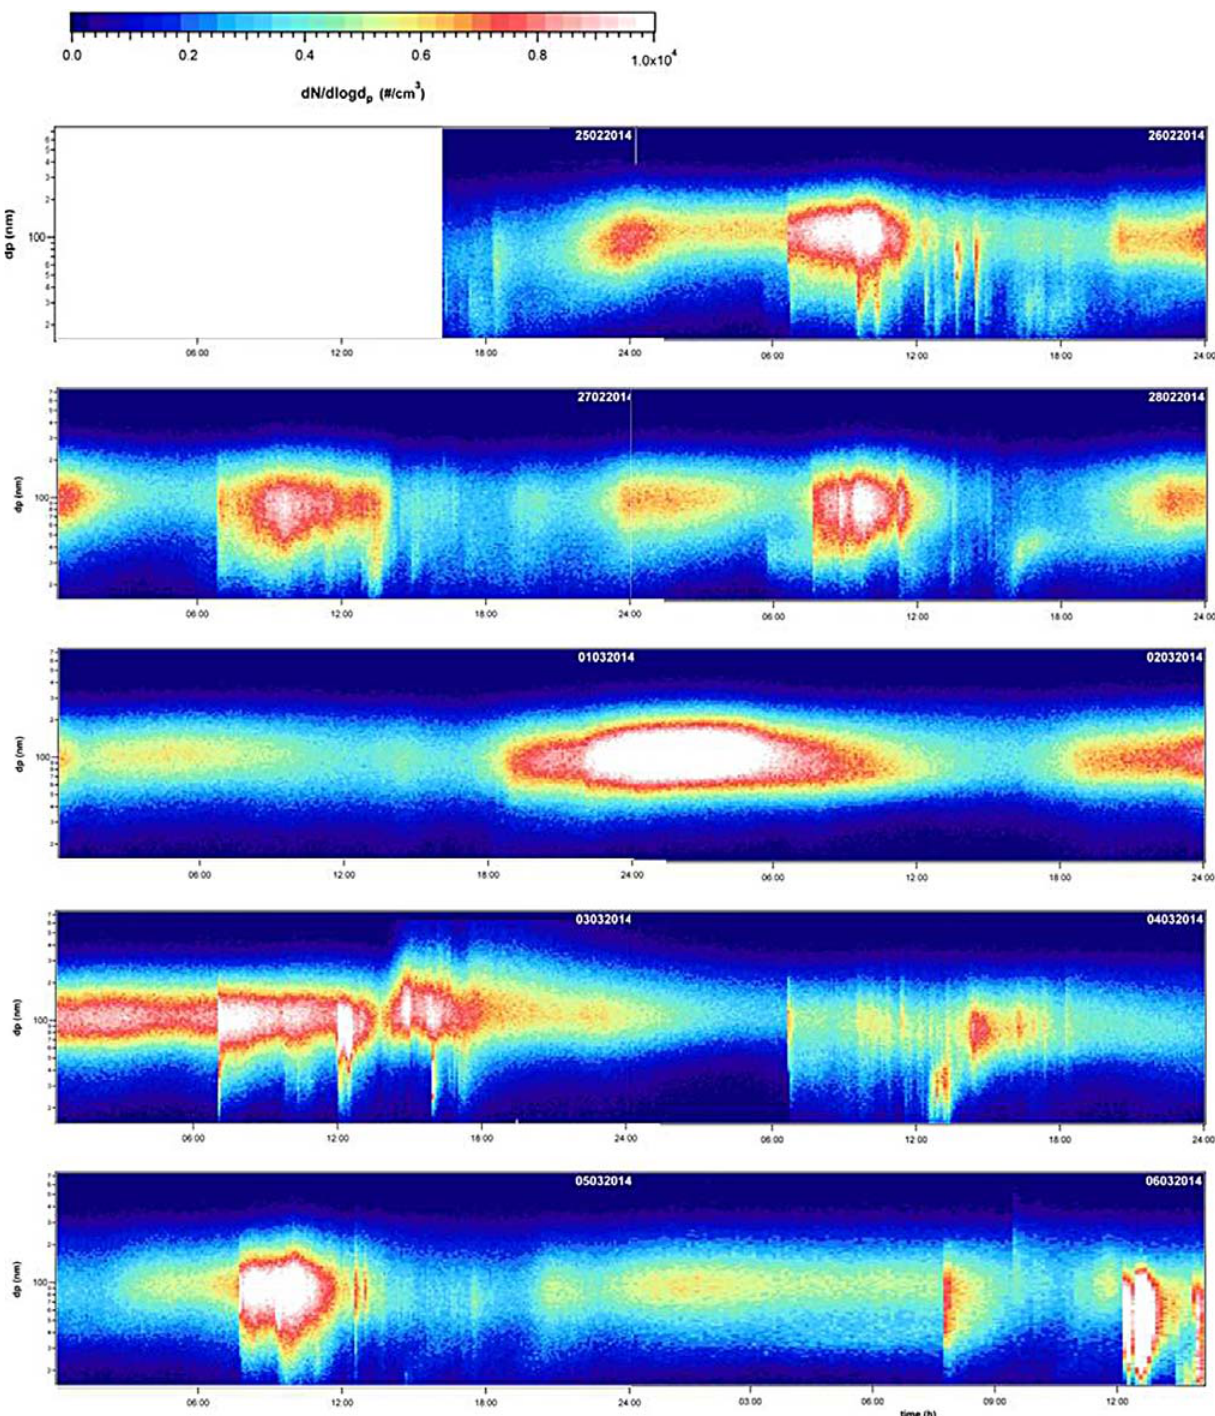
Figure 2: Number concentration (particle cm –3 ) and size distribution of the particles continuously measured in Room1 of the company of spatial in- formatics and graphic design in Ljubljana, Slovenia from February 25 to March 6, 2014. White color represents the concentrations above 10 × 10 3 particle cm –3